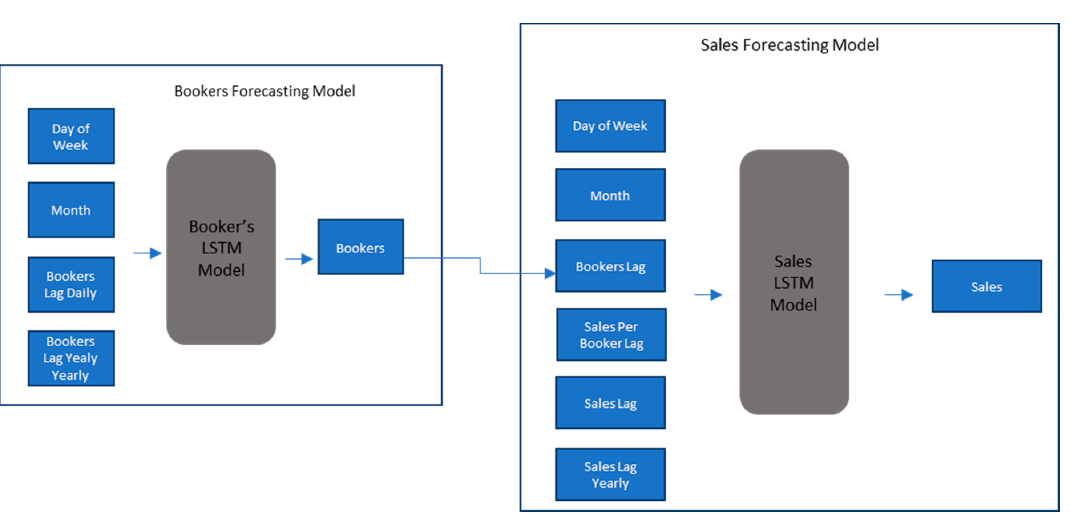
Figure 4. LSTM Network with Dropout Cells. Case 3: Stochastic noise in predicted active booker count and sales: In this approach, instead of using dropouts at the time of prediction, various noise distributions are used to add uncertainty in the models. Uncertainty can exist in both active booker count and sales forecasting models. Gaussian, uniform, triangular [28], logistic [29], and Gumbel [30] distributions are used for the noise